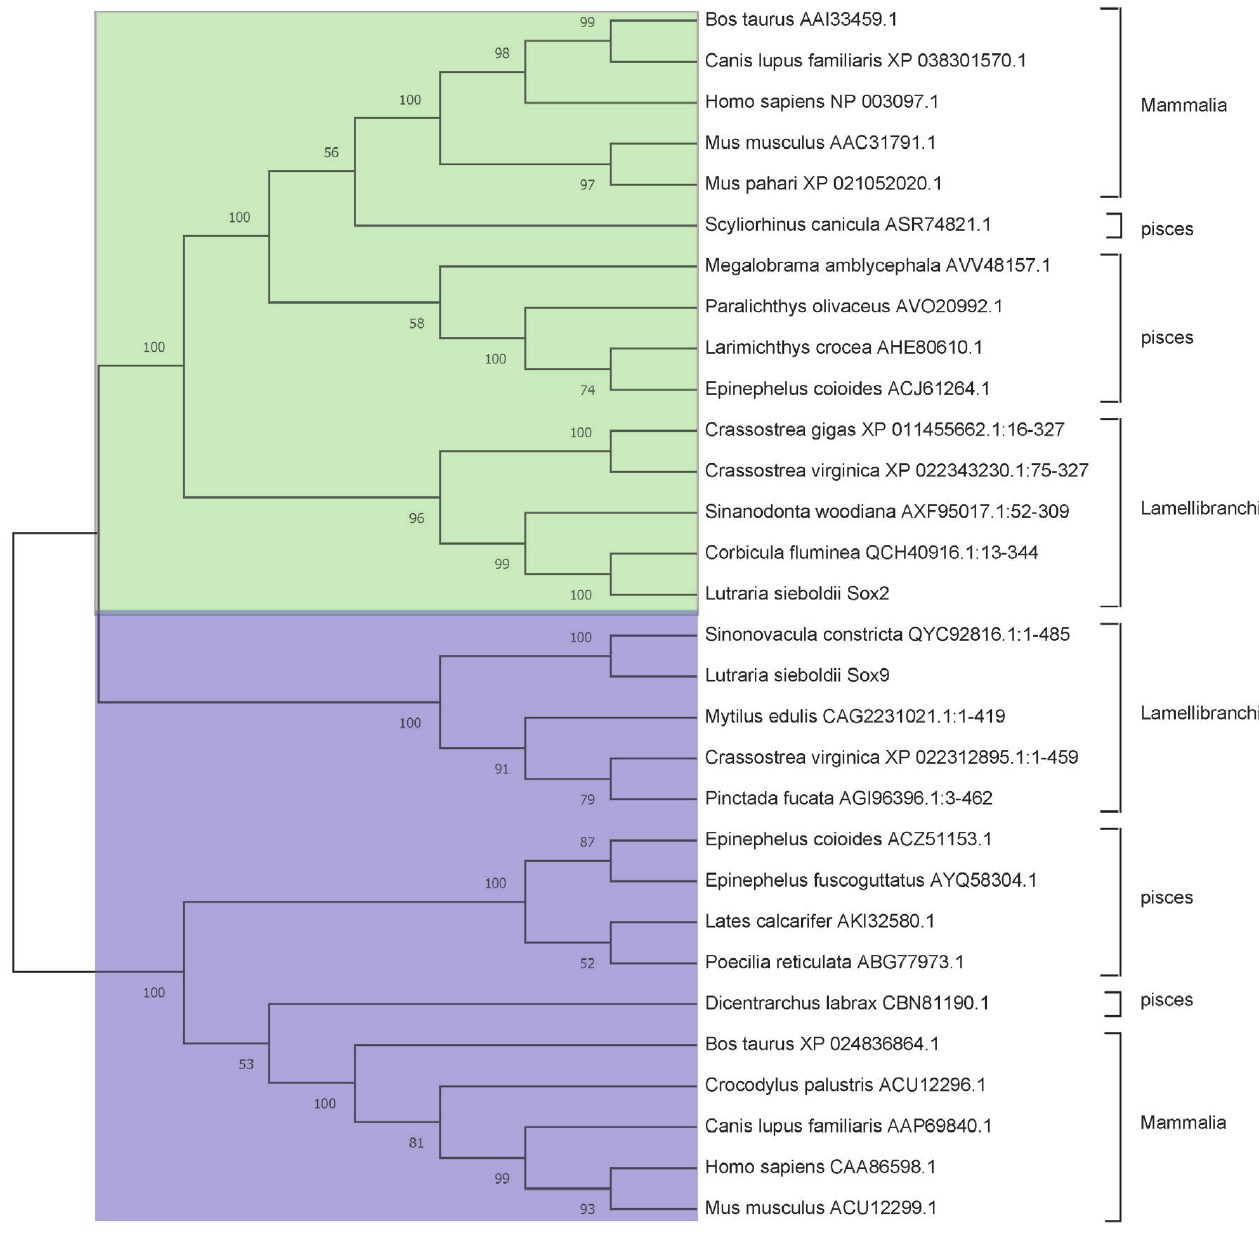
Figure 2. Phylogenetic analyses of the (green) LsSox2 and (purple) LsSox9 proteins.